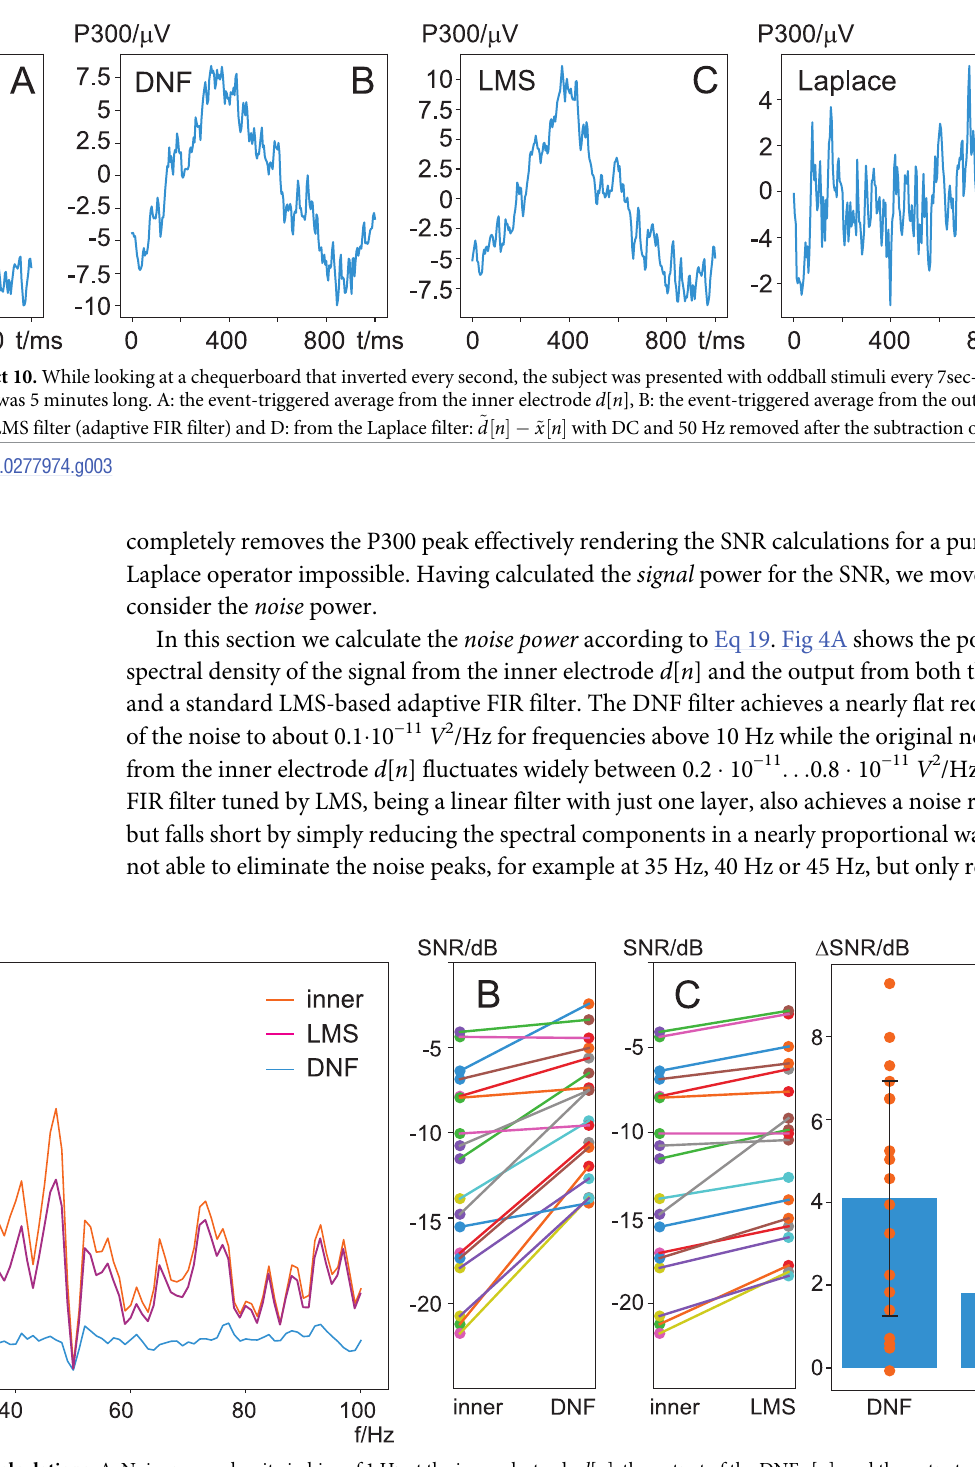
Fig 4. Noise density and SNR calculations. A: Noise power density in bins of 1 Hz at the inner electrode d [ n ], the output of the DNF e [ n ], and the output of the standard LMS-based adaptive FIR filter. B: SNR in dB calculated with Eq 19 at the inner electrode d [ n ] and the output e [ n ] of the DNF for every subject. C: SNR in dB calculated with Eq 19 for the standard LMS-based adaptive FIR filter for every subject. D: The SNR differences from C) and D) for DNF ( Δ SNR DNF = 4.1 ± 2.8 dB) and LMS-based FIR filter ( Δ SNR LMS = 1.8 ± 1.3